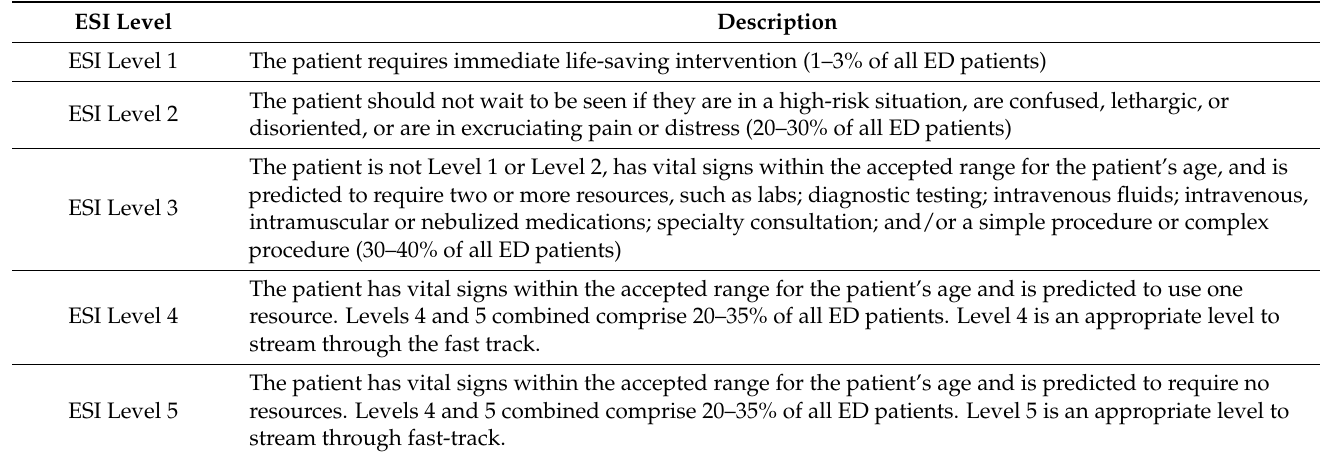
Table 3. Emergency Severity Index (ESI)